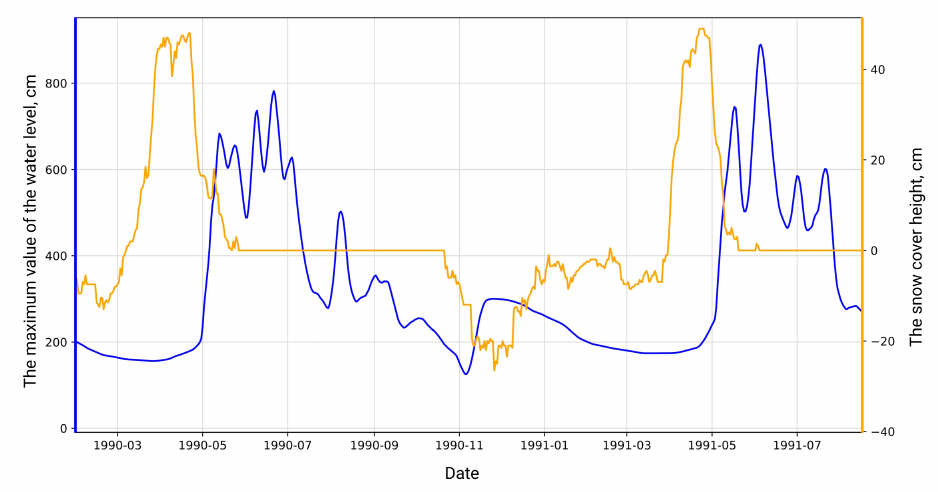
Figure 8. The dependence of the amount of water on the snow